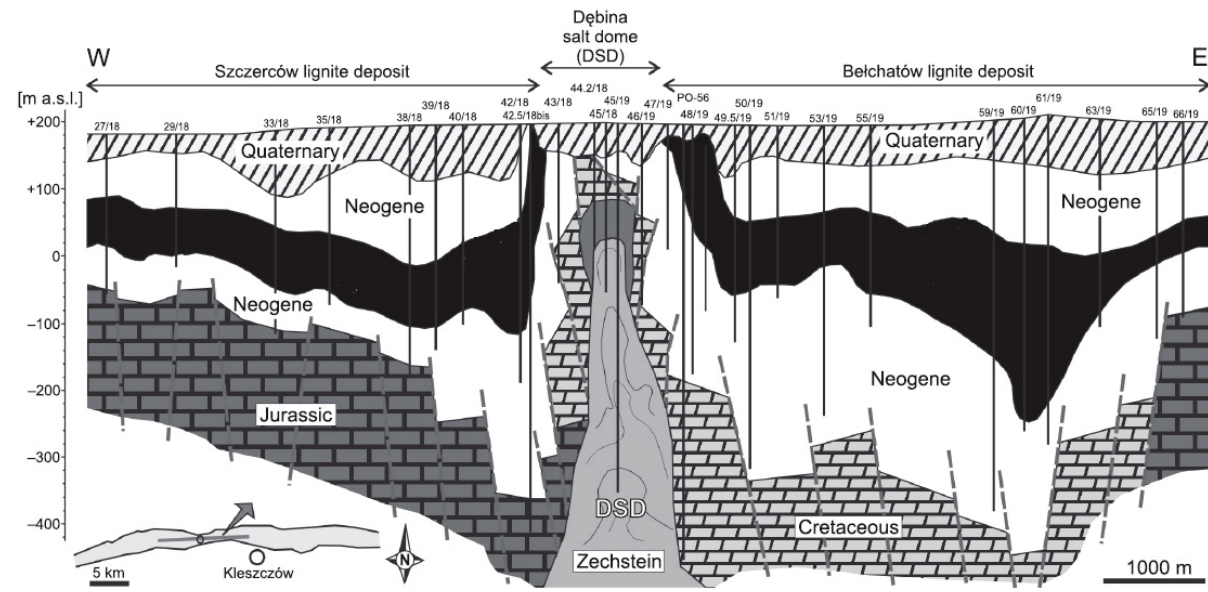
Fig. 1. Geological structure of the Bełchatów coal deposit (after [13], [23])